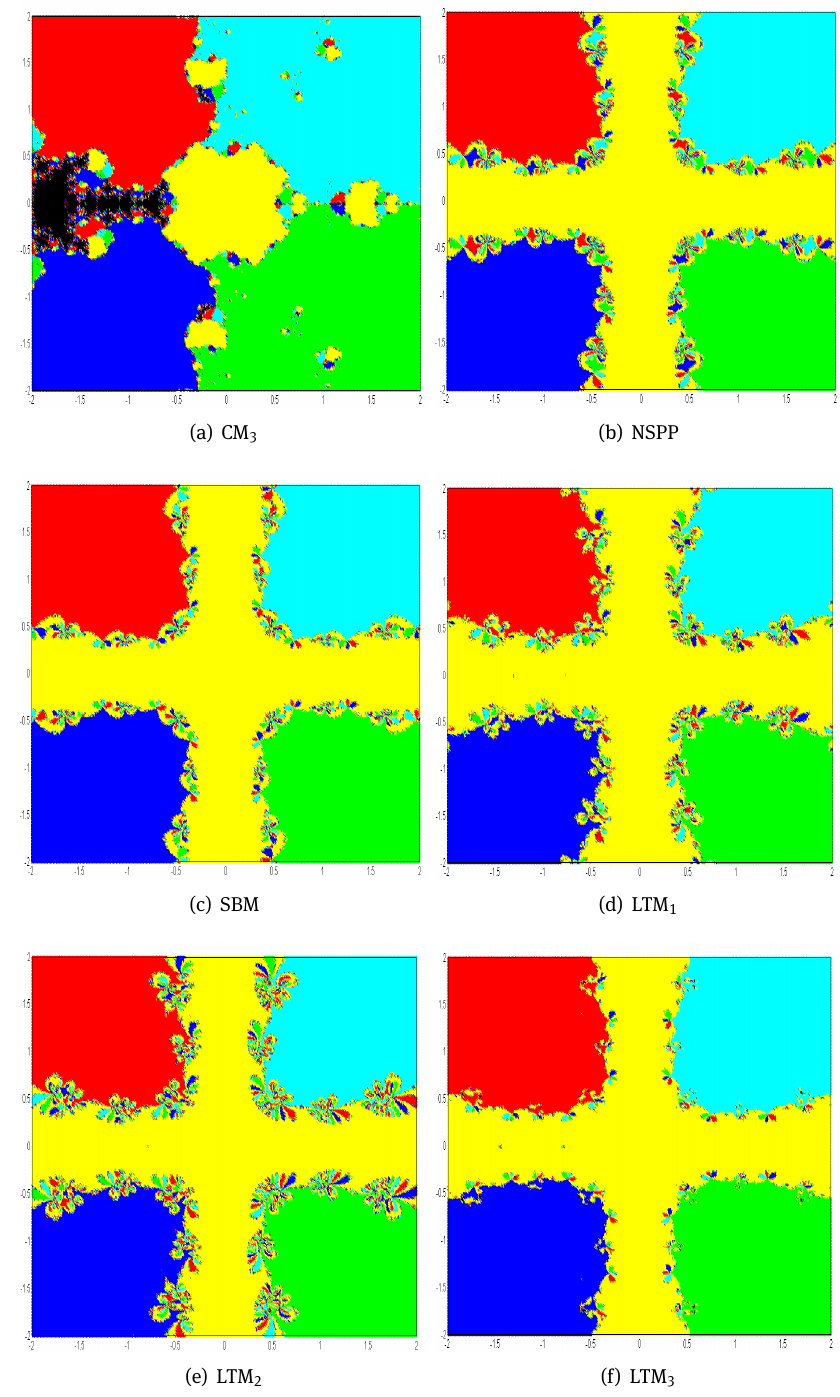
Figure 5: Basins of attraction of the methods CM 3 , NSPP, SBM, LTM 1 , LTM 2 and LTM 3 respectively for P 2 ( z ) = z 5 + z